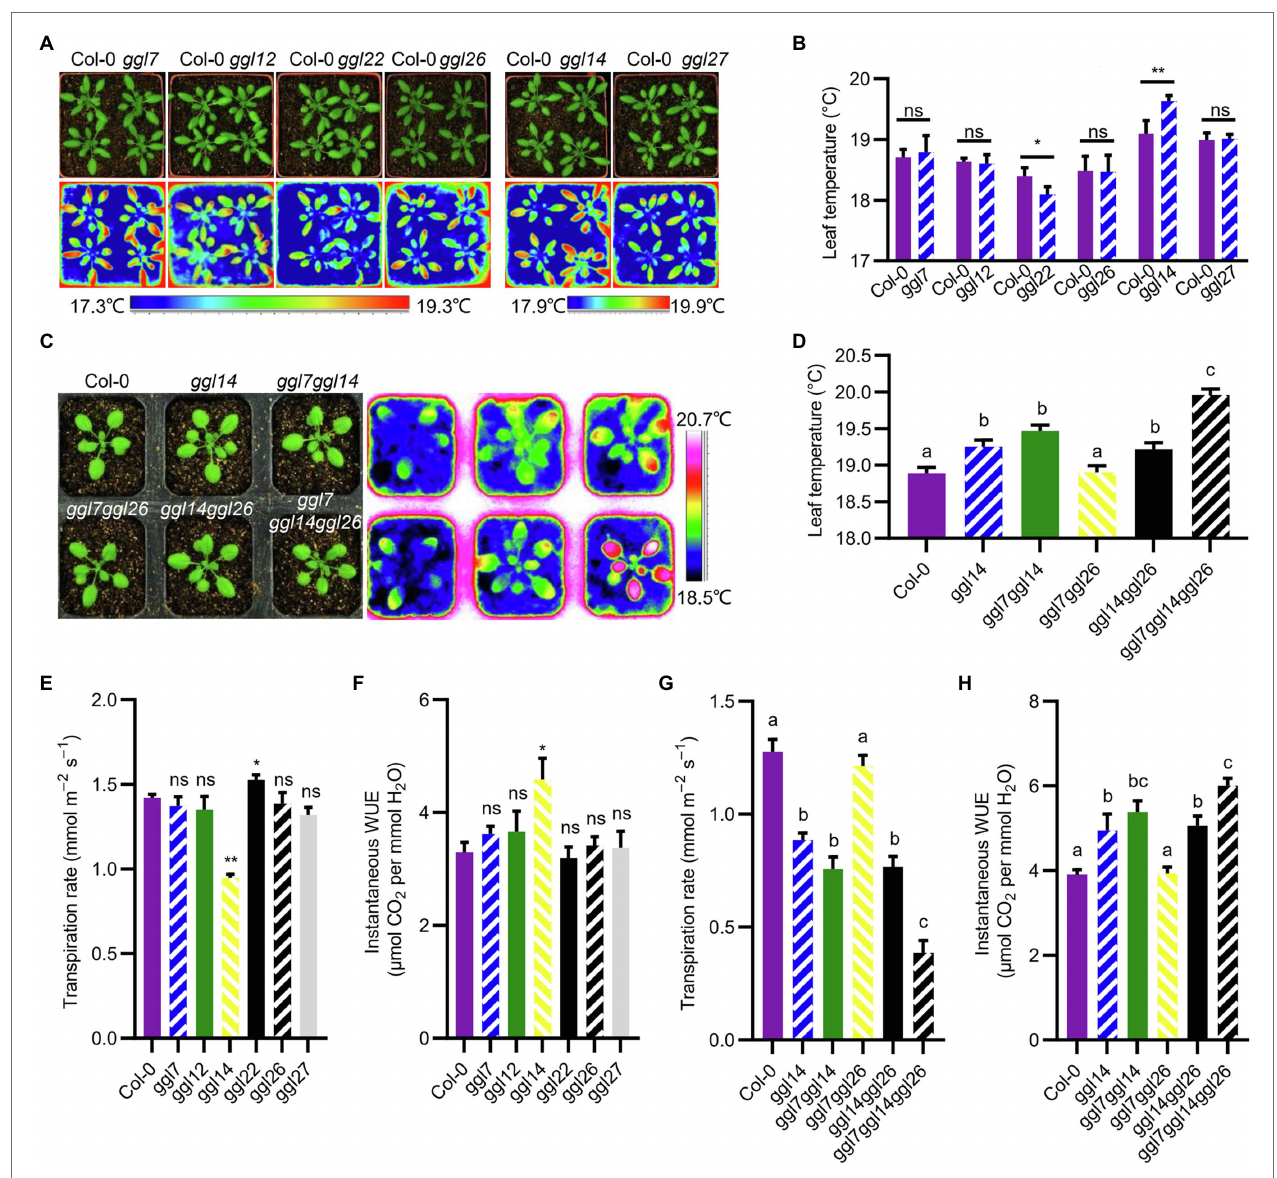
FIGURE 6 | Leaf temperature, transpiration rate, and instantaneous water use efficiency (WUE) of ggl mutants. (A) Photograph (up) and infrared thermal imaging (down) of Col-0 and ggl single mutants. (B) Quantification and statistical analyses of leaf temperature of Col-0 and ggl single mutant plants in (A) . Values are means ± SE ( n = three independent experiments, each with four plants per genotype). * p < 0.05; ** p < 0.01; ns, no significant difference; Student’s t -test. (C) Photograph (left) and infrared thermal imaging (right) of Col-0, ggl14 , the corresponding double mutant, and triple mutant plants. (D) Quantification and statistical analyses of leaf temperature of Col-0, ggl14 , the corresponding double mutant, and triple mutant plants in (C) . Values are means ± SE ( n = three independent experiments, each with six plants per genotype). Different letters indicate statistically significant differences ( p < 0.05) by one-way ANOVA and Tukey’s test analyses. (E–H) The transpiration rate and WUE of ggl mutants were measured using a portable gas exchange system (LI-6400XT). Values are means ± SE ( n = three independent experiments, each with six plants per genotype). * p < 0.05; ** p < 0.01; ns, no significant difference; Student’s t -test (E, F) , and different letters indicate statistically significant differences ( p < 0.05) by one-way ANOVA and Tukey’s test analyses (G, H) . Quantification of leaf temperature by the software ThermaCAM Researcher Professional 2.10 (B, D)